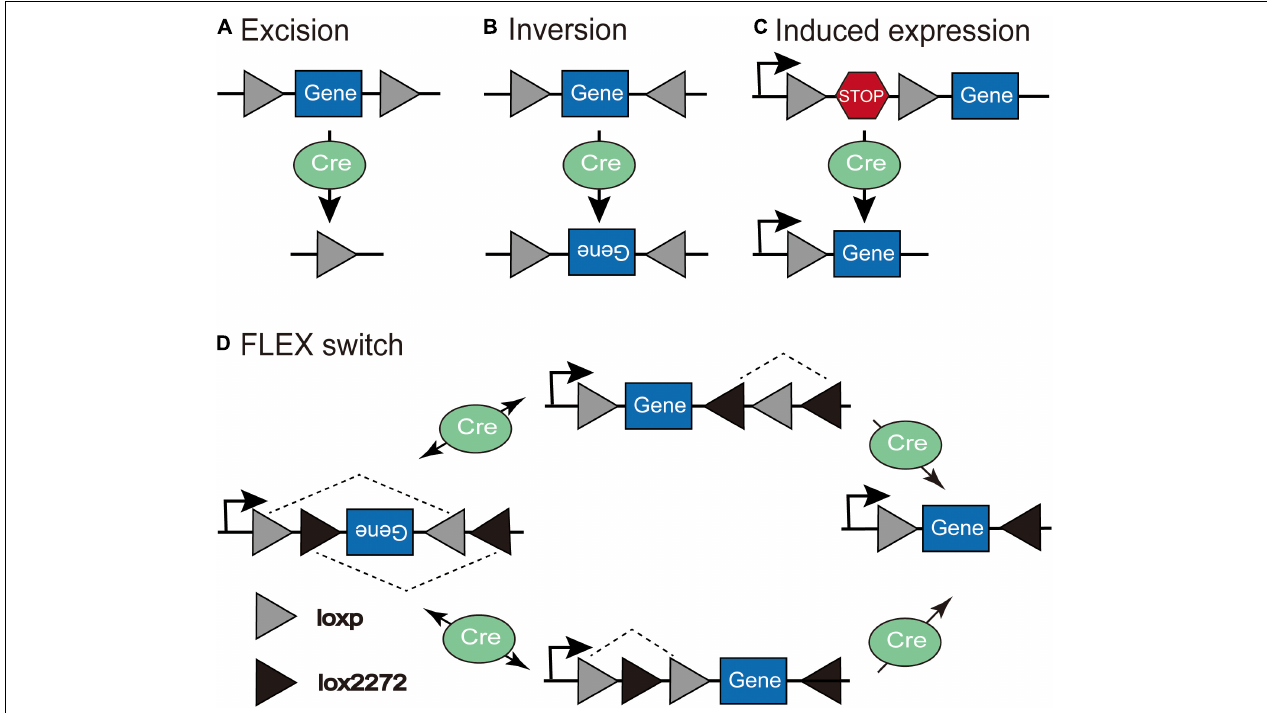
FIGURE 2 | The schematic depiction of the Cre-LoxP system. (A) Excision: Cre recombinase cuts the coding sequences between loxP sites in the same orientation. (B) Inversion: Cre recombinase leads to the inversion of coding sequences between loxP sites in the opposite orientation. (C) Induced expression: Cre recombinase excises the loxP-flanked “STOP” sequence to induce the expression of the transgene. (D) In the Flip-Excision (FLEX) switch system, loxP and lox2272 are heterotypic and antiparallel; therefore, after the inversion and subsequent excision, the expression of transgene can be achieved through Cre-mediated inversion of the reverse-constructed coding sequence (Adapted from Atasoy et al.,